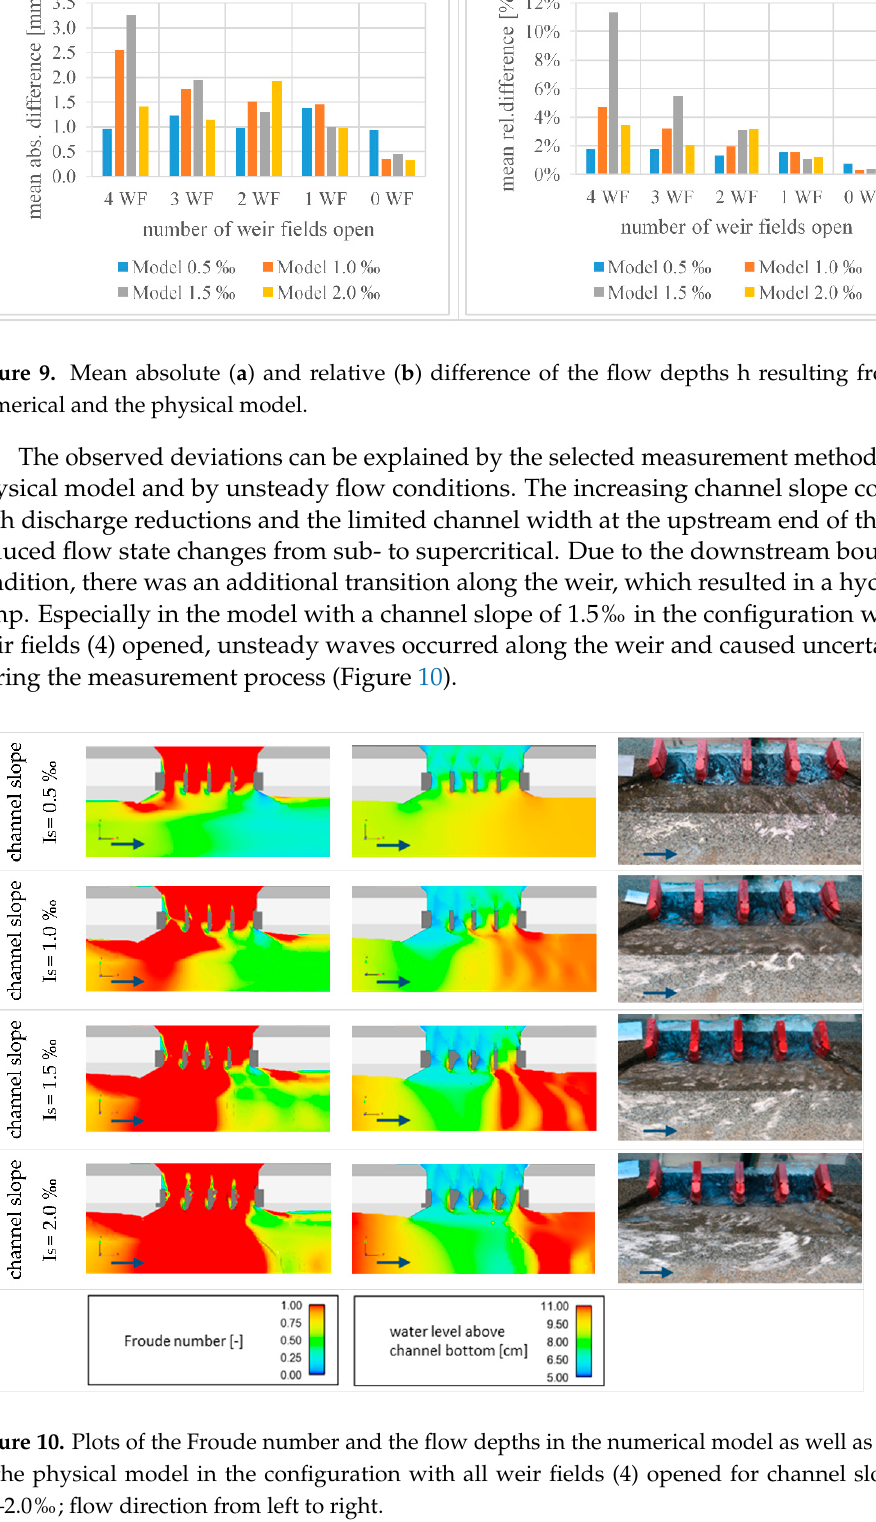
Figure 8. Profiles of the flow depths h above the weir crest determined in the numerical and in the physical model along the weir depending on the number of weir fields opened for channel slopes of 0.5–2.0‰ (including position of weir fields 1–4); flow direction from left to right.